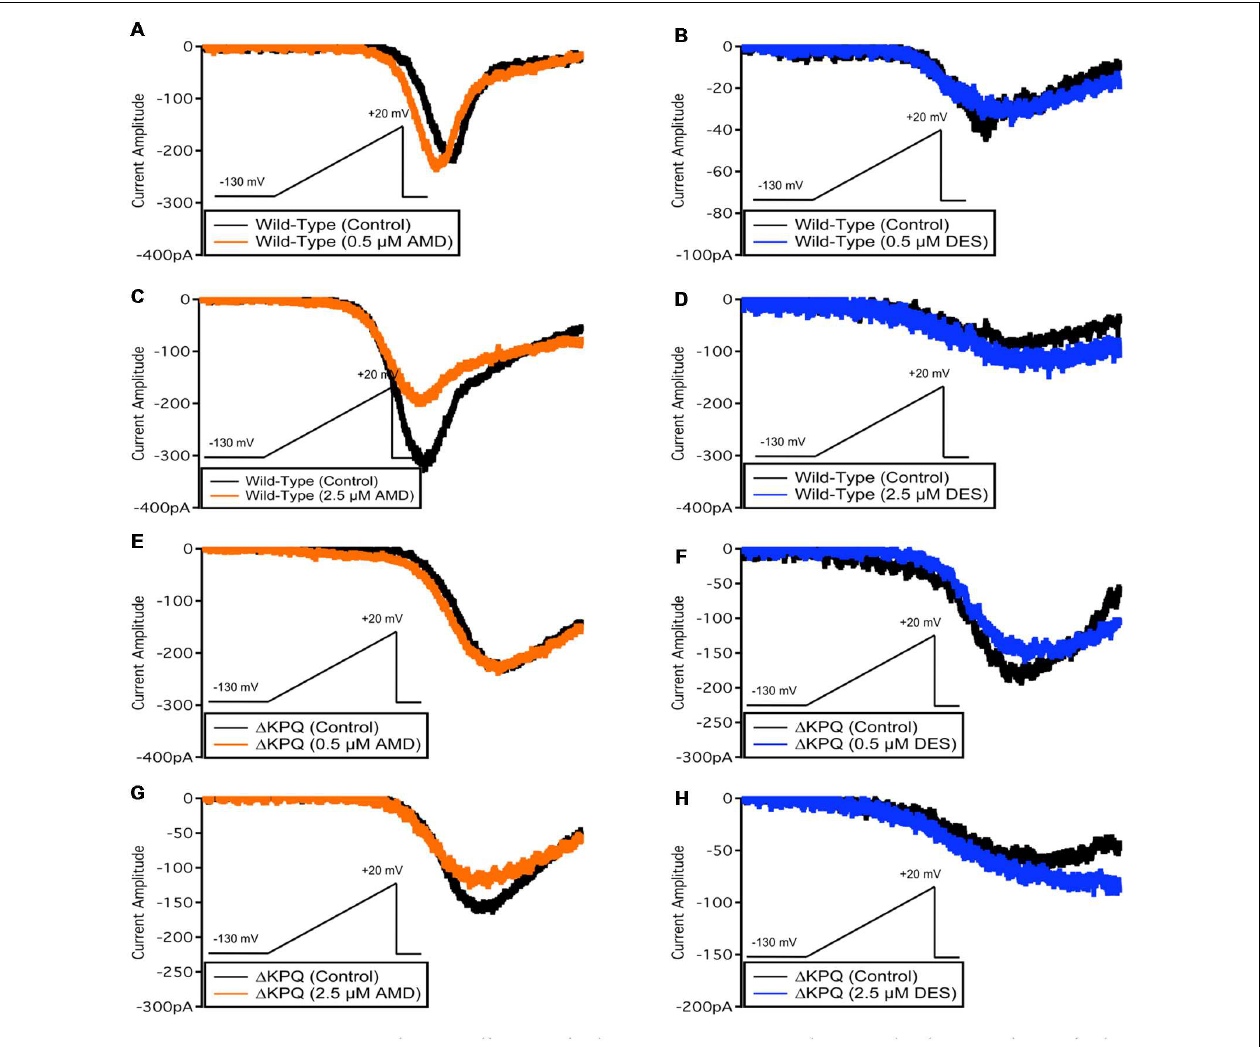
FIGURE 7 | Representative sodium window currents. (A–H) Each panel shows the window currents in Na V 1.5 or (cid:49) KPQ before and after the perfusion of either 0.5 or 2.5 µ M AMD or DES. Black curves represent control (0 µ M drug solution), orange curves represent AMD at either 0.5 or 2.5 µ M, and blue curves represent DES at either 0.5 or 2.5 µ